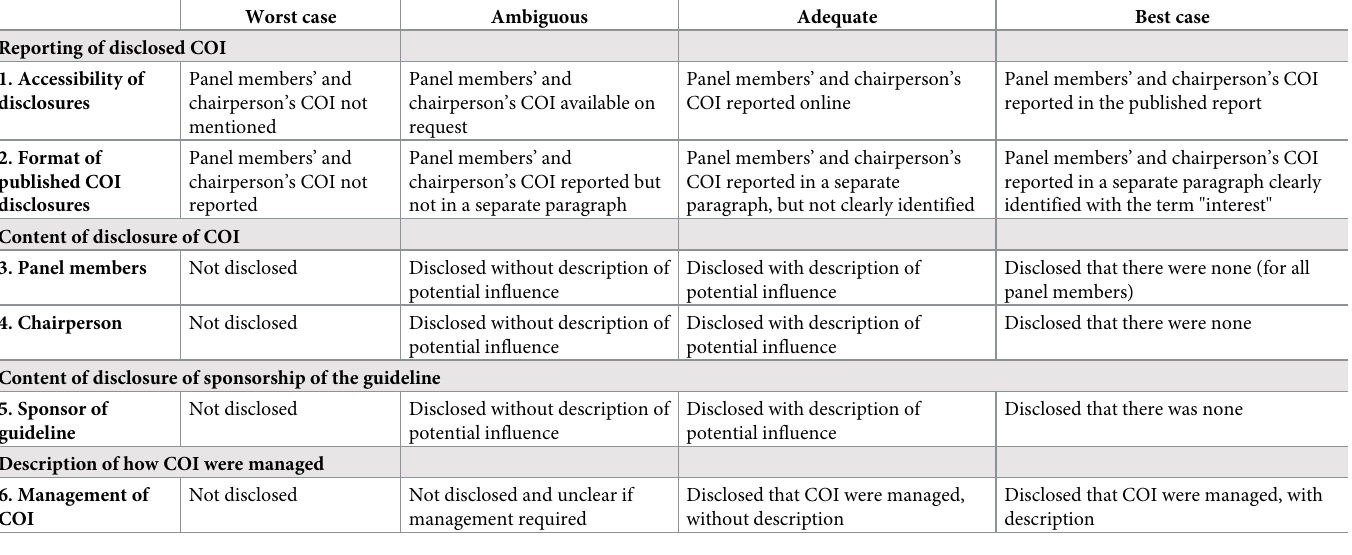
Table 1. Degrees of quality of reporting of conflicts of